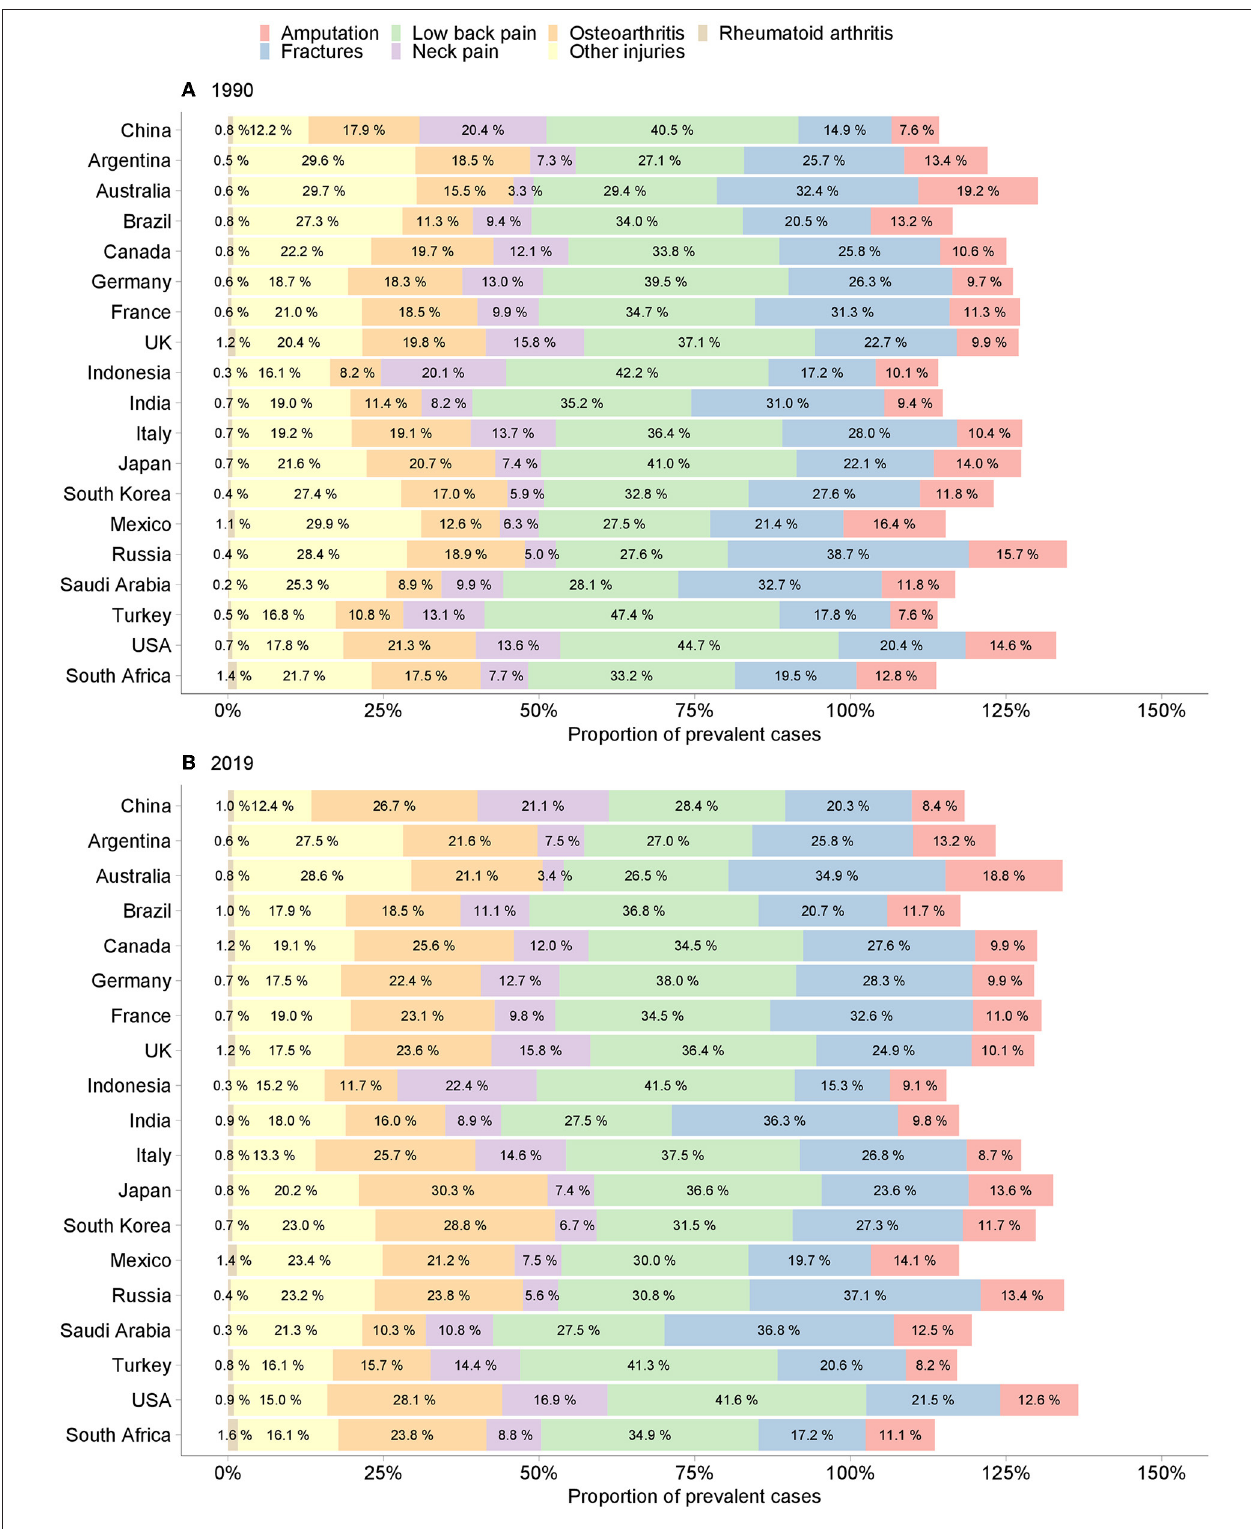
FIGURE 1 | Proportion of prevalent cases of musculoskeletal rehabilitation needs in the G20 countries. (A) 1990. (B) 2019.